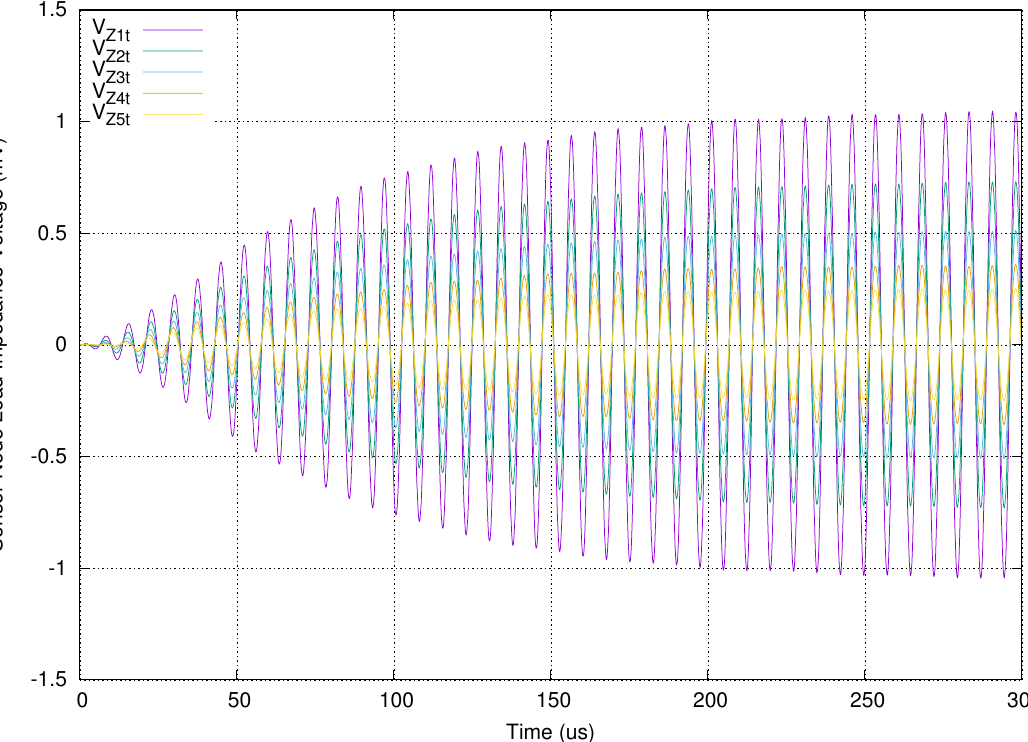
Figure 8. Transient behavior when all sensor nodes are connected.